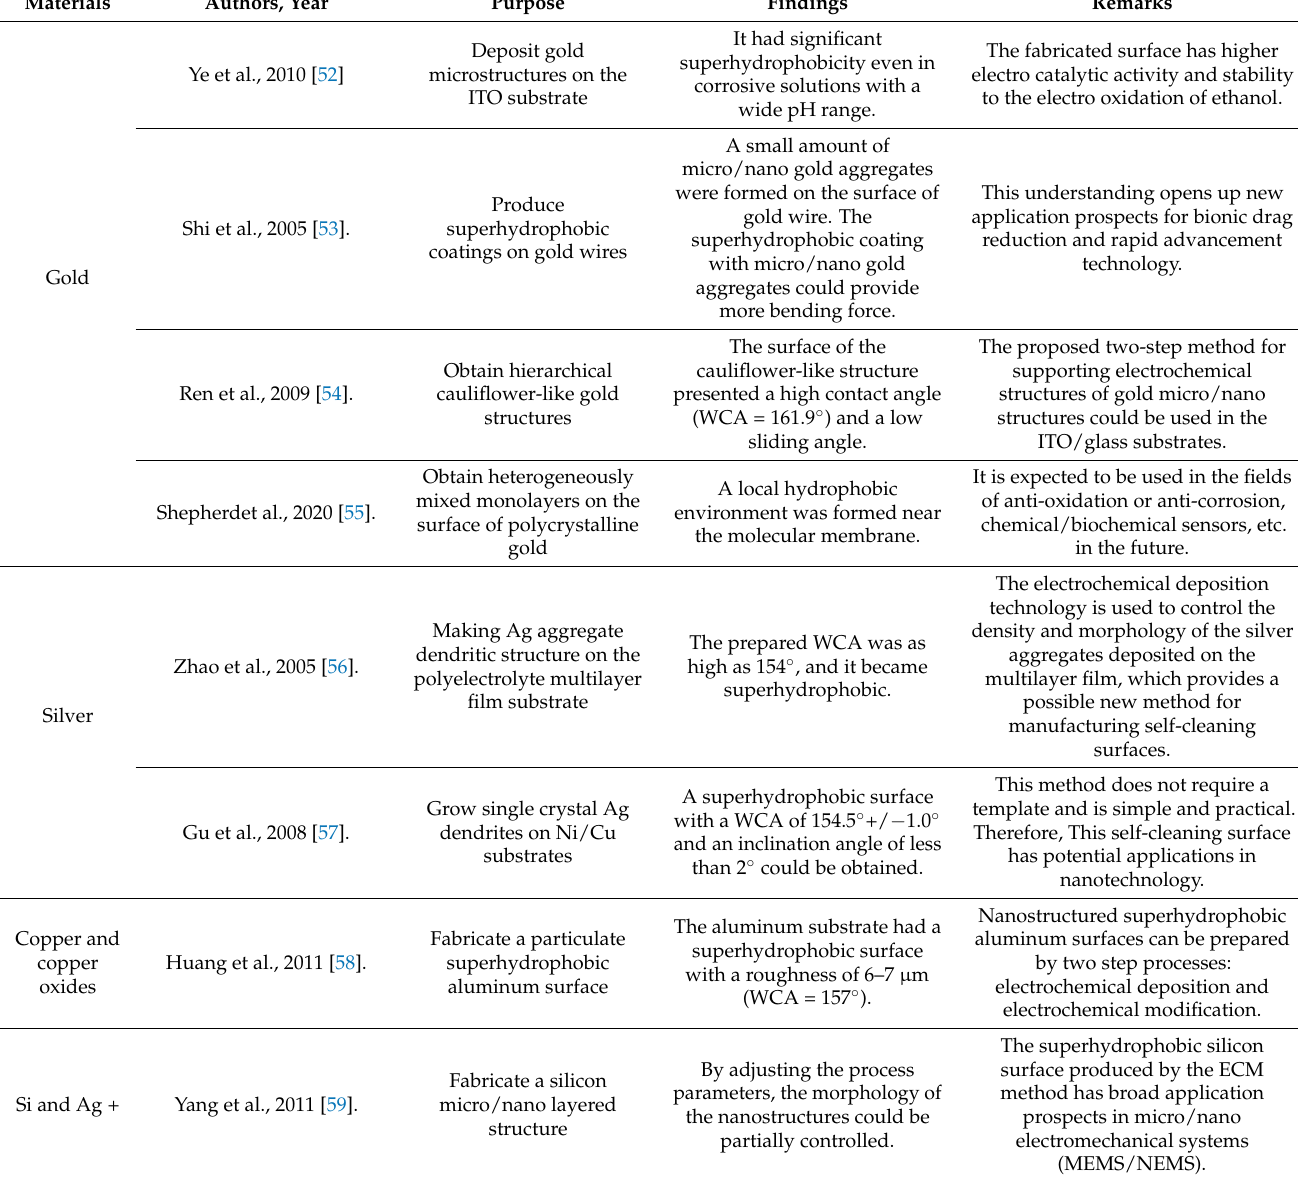
Table 4. Summary of electrochemical reduction process described in the text grouped by materials